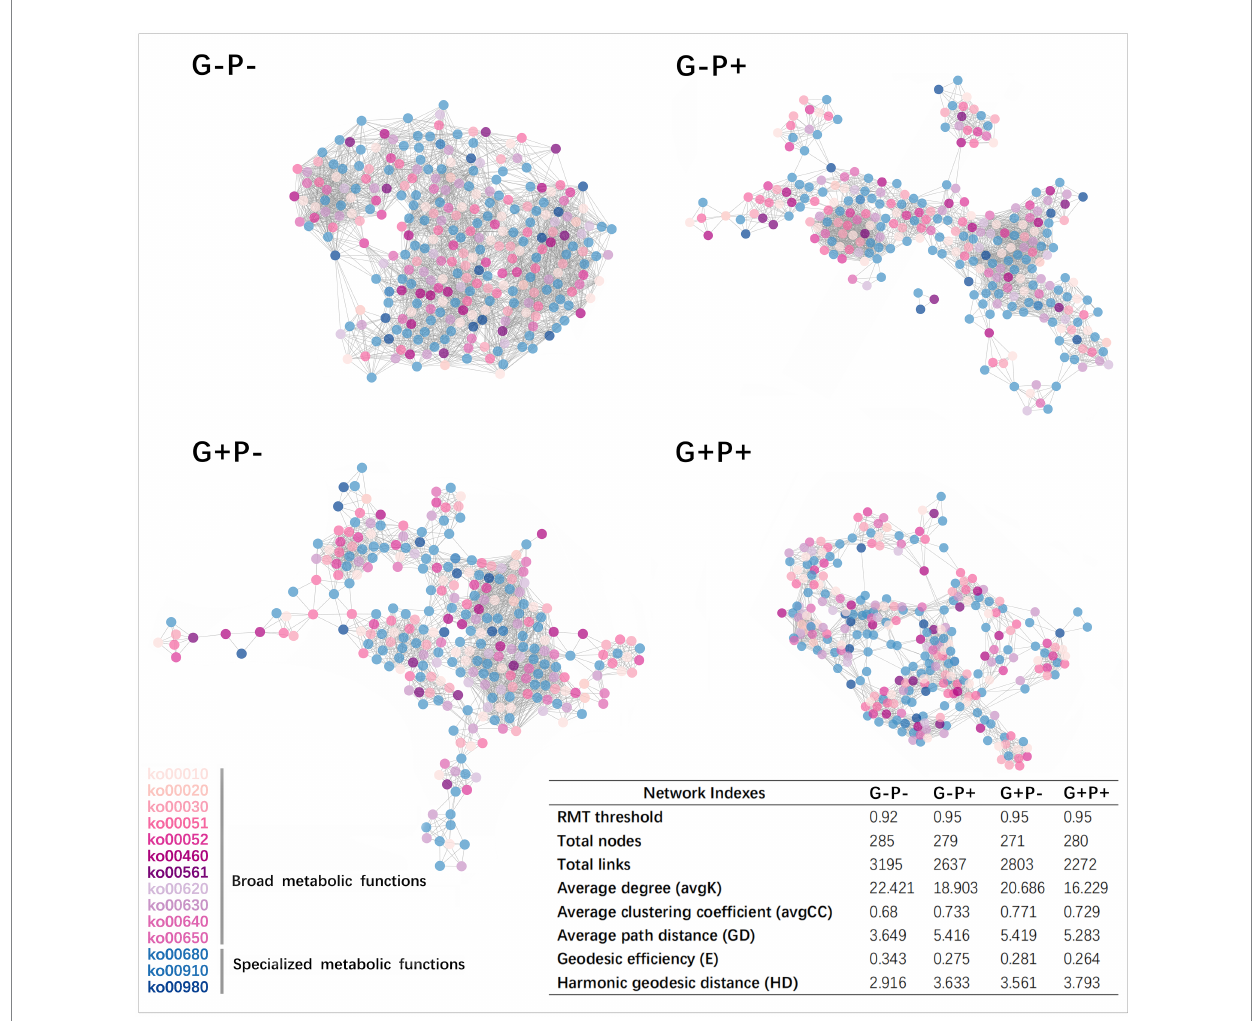
FIGURE 3 Functional gene co-occurrence networks of soil microbial communities under four grazing by P-addition treatments in a steppe grassland. For a concise visualization, only the 300 most abundant genes in each sample were selected. Five metabolic functions were excluded because of their low abundance. Nodes represent individual genes in the three specialized metabolic functions and 11 broad metabolic functions. The colors of the nodes are the same as that of the Pathway ID shown in legend at the bottom left (Supplementary Table S1), and the table at the bottom right shows important network